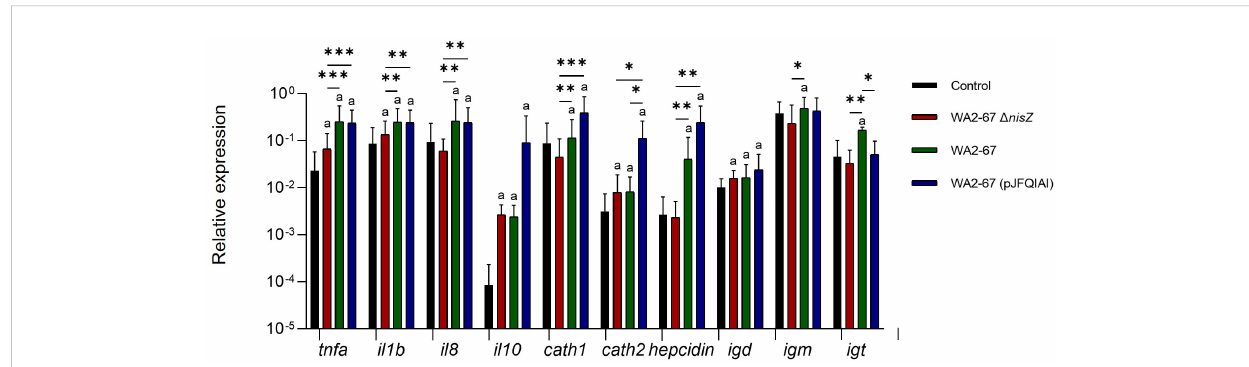
FIGURE 3 Transcriptional response of splenic leukocytes to different LAB strains: L. cremoris WA2-67 D nisZ , L. cremoris WA2-67 and L. cremoris WA2-67 (pJFQIAI). Splenic leukocytes were incubated with 1 x 10 6 cfu/ml of each bacterial strain at 20°C for 24 h. Subsequently, RNA was extracted and the levels of transcription of different genes were analyzed by real-time PCR. Relative gene expression levels were normalized to the transcription of the housekeeping gene bactin . Data are shown as mean fold change + SD (n = 8). The letter (a) represents transcription levels signi fi cantly different than those observed in cells not exposed to bacterial strains (control), while the asterisks indicate levels signi fi cantly different between bacterial treatments as indicated (* p ≤ 0.05, ** p ≤ 0.01 and *** p ≤